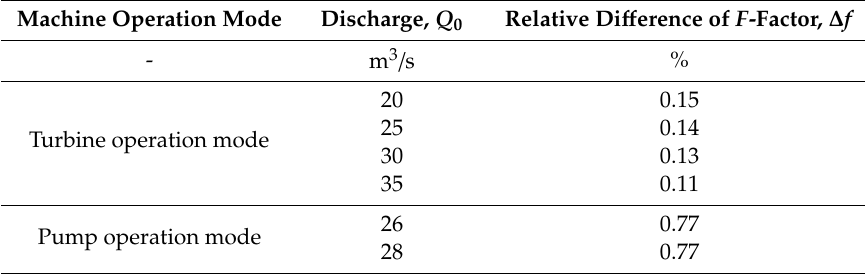
Table 1. The relative di ff erences of F -factor, ∆ f , determined for the entire penstock for the assumed discharge values in the both machine operation modes.